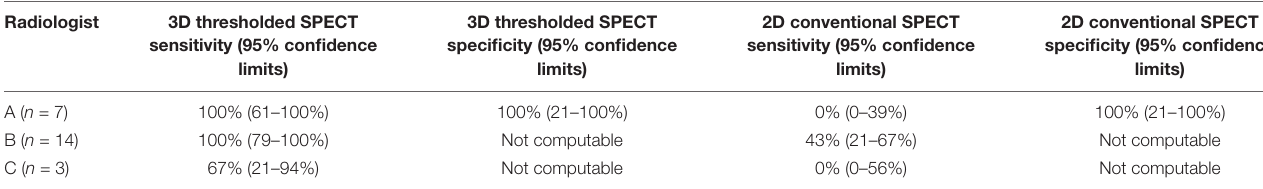
TABLE 3 | Sensitivities and specificities for conventional (“2D”) brain SPECT and 3D thresholded brain SPECT scans in predicting improvement in patients with a diagnosis of ADHD associated with different nuclear medicine radiologists reading the scans.